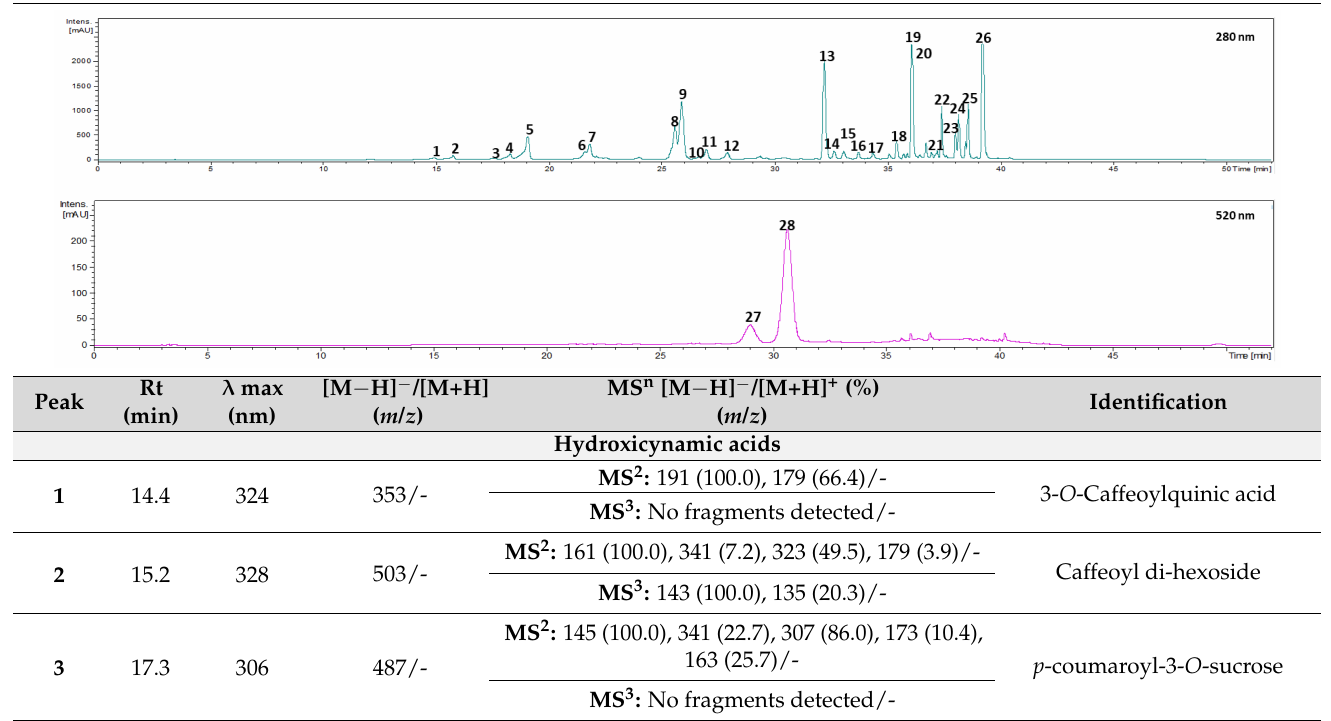
Table 2. (Poly)phenolic profile of Prunus lusitanica